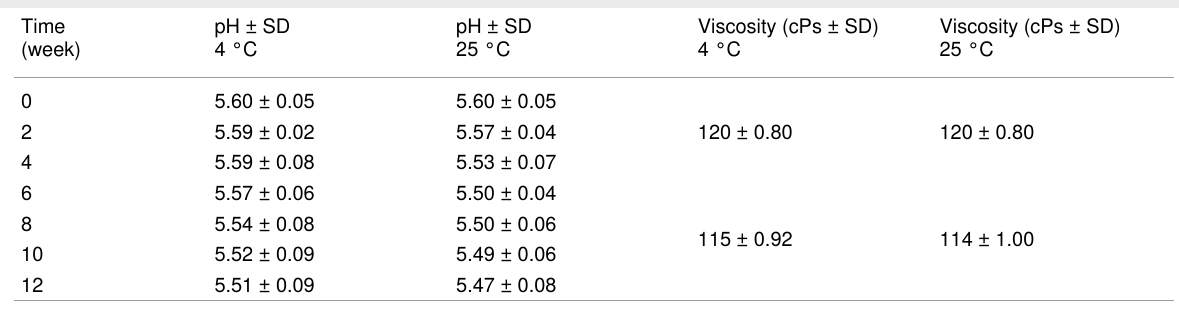
Table 3: Stability of ethosomal gels a .